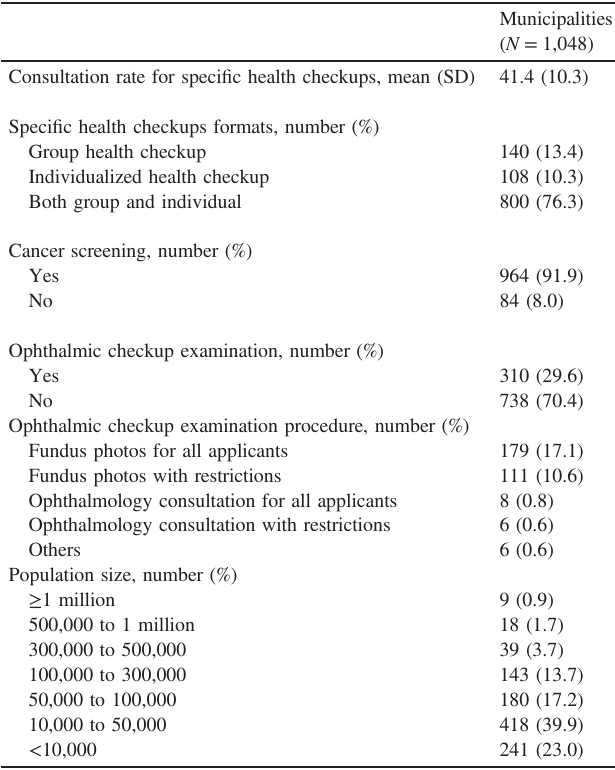
Table 1. Data of study variables from questionnaire